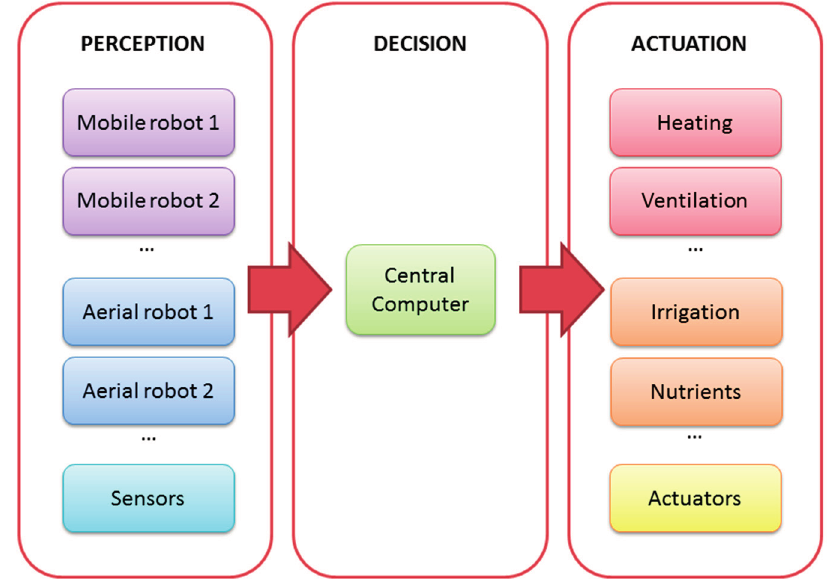
Figure 1. Architecture of the complete